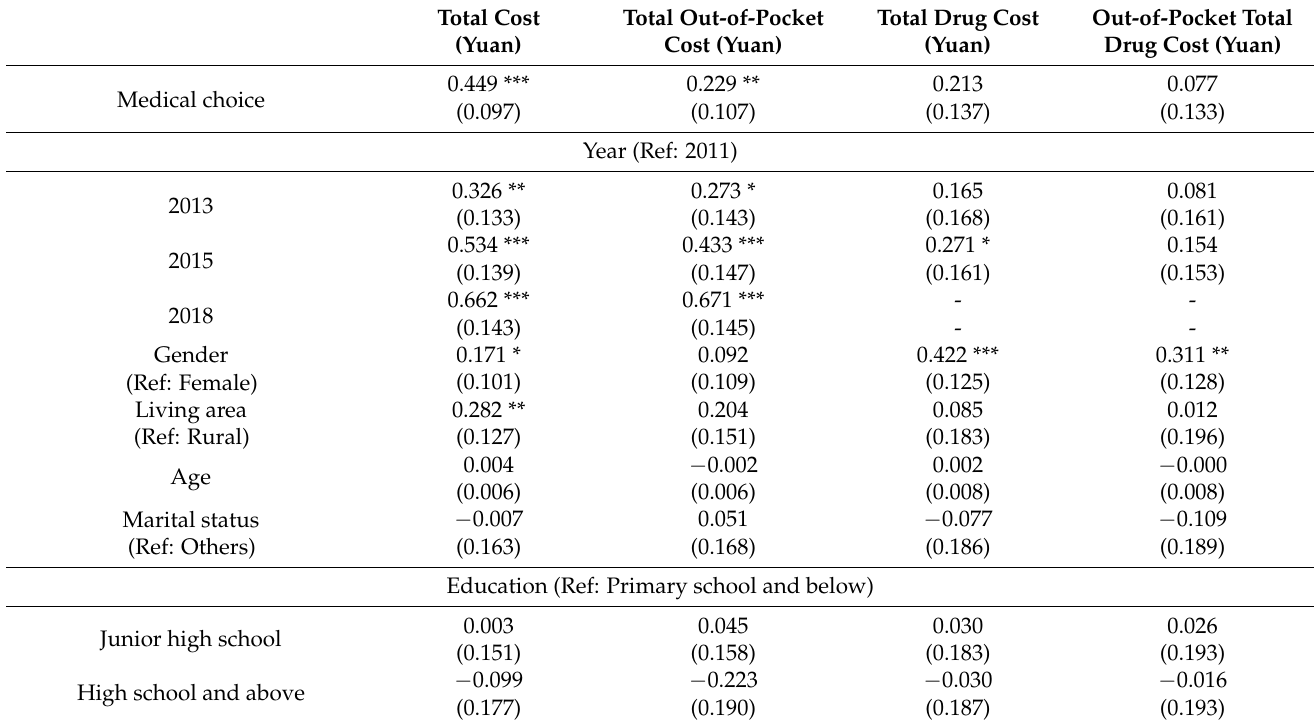
Table 4. The effect of medical choice on health costs